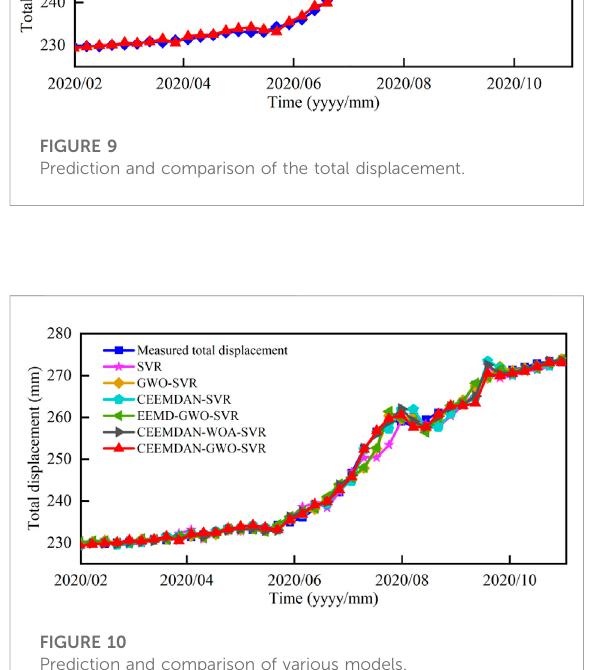
FIGURE 10 Prediction and comparison of various